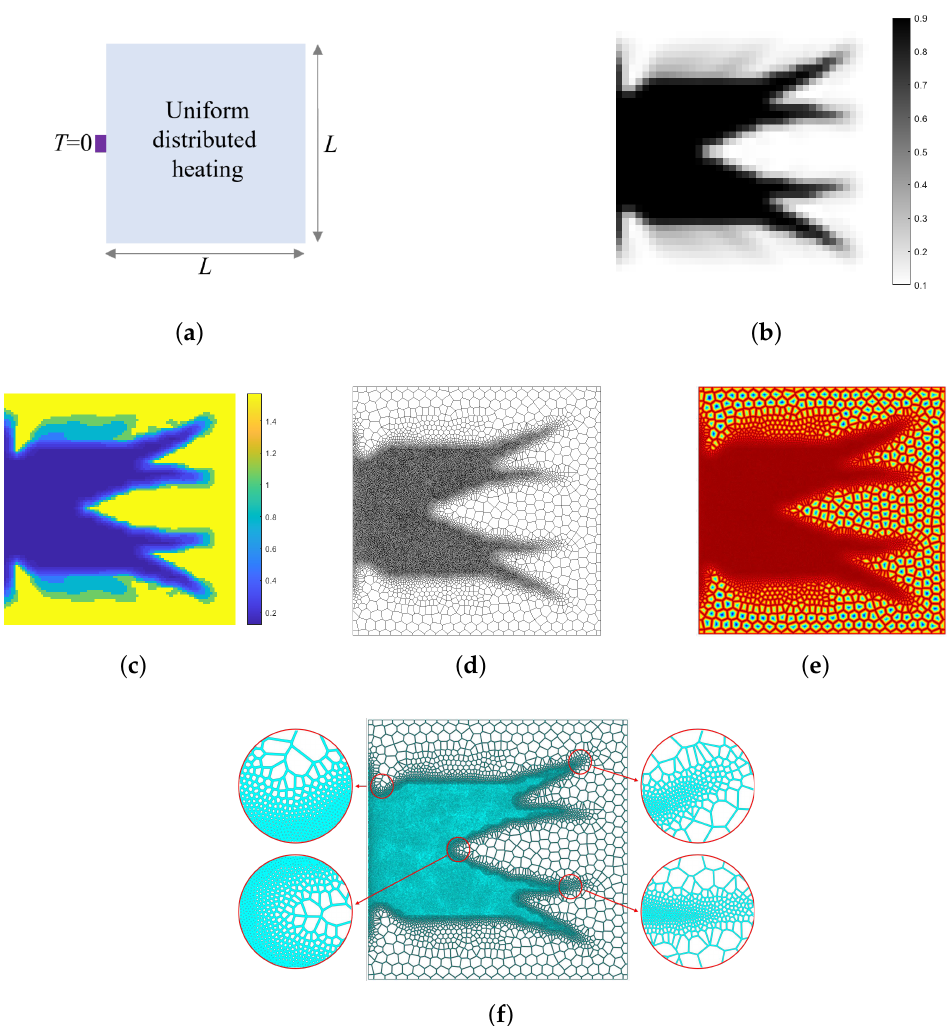
Figure 5. Results of the uniform distributed heating (I): ( a ) the numerical model; ( b ) the relative density distribution; ( c ) the mesh size function; ( d ) the skeleton of the Voronoi-GSCS; ( e ) the signed distance function of the skeleton; ( f ) the reconstructed Voronoi-GSCS.